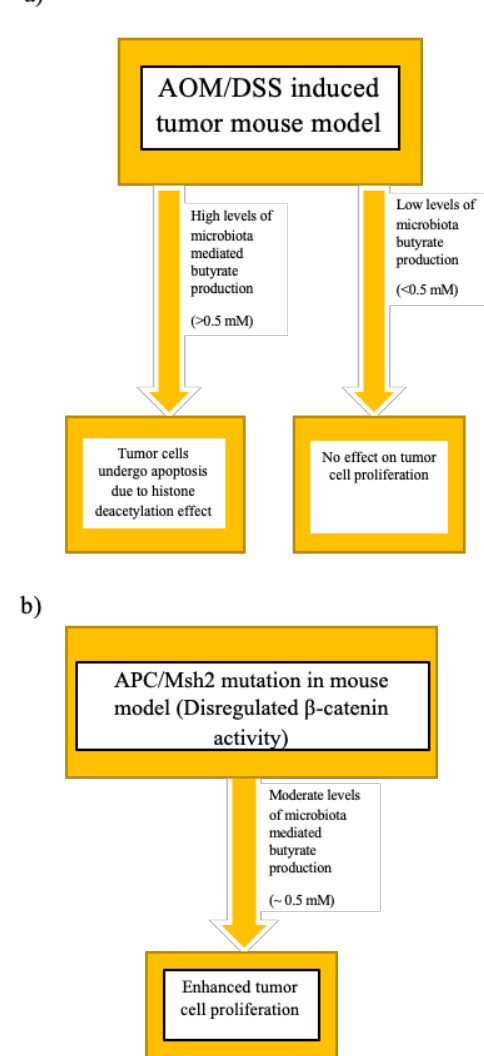
Figure 4. Butyrate paradox. ( a ) Effect of different levels of butyrate in Azoxymethane/Dextran sodium sulphate (AOM/DSS) treated mouse model. DSS is a colon epithelium disrupting agent that can induce colitis and AOM is a genotoxin. Combined AOM and DSS treatment in mice creates a model similar to that of human CRC to study the effects of inflammation and underlying genetic mutations in colon epithelium cells on microbiota dysbiosis and tumourigenesis [127]; ( b ) effect of moderate levels of butyrate on adenomatous polyposis coli (APC)/ MutS protein homolog 2 (Msh2) mouse model.